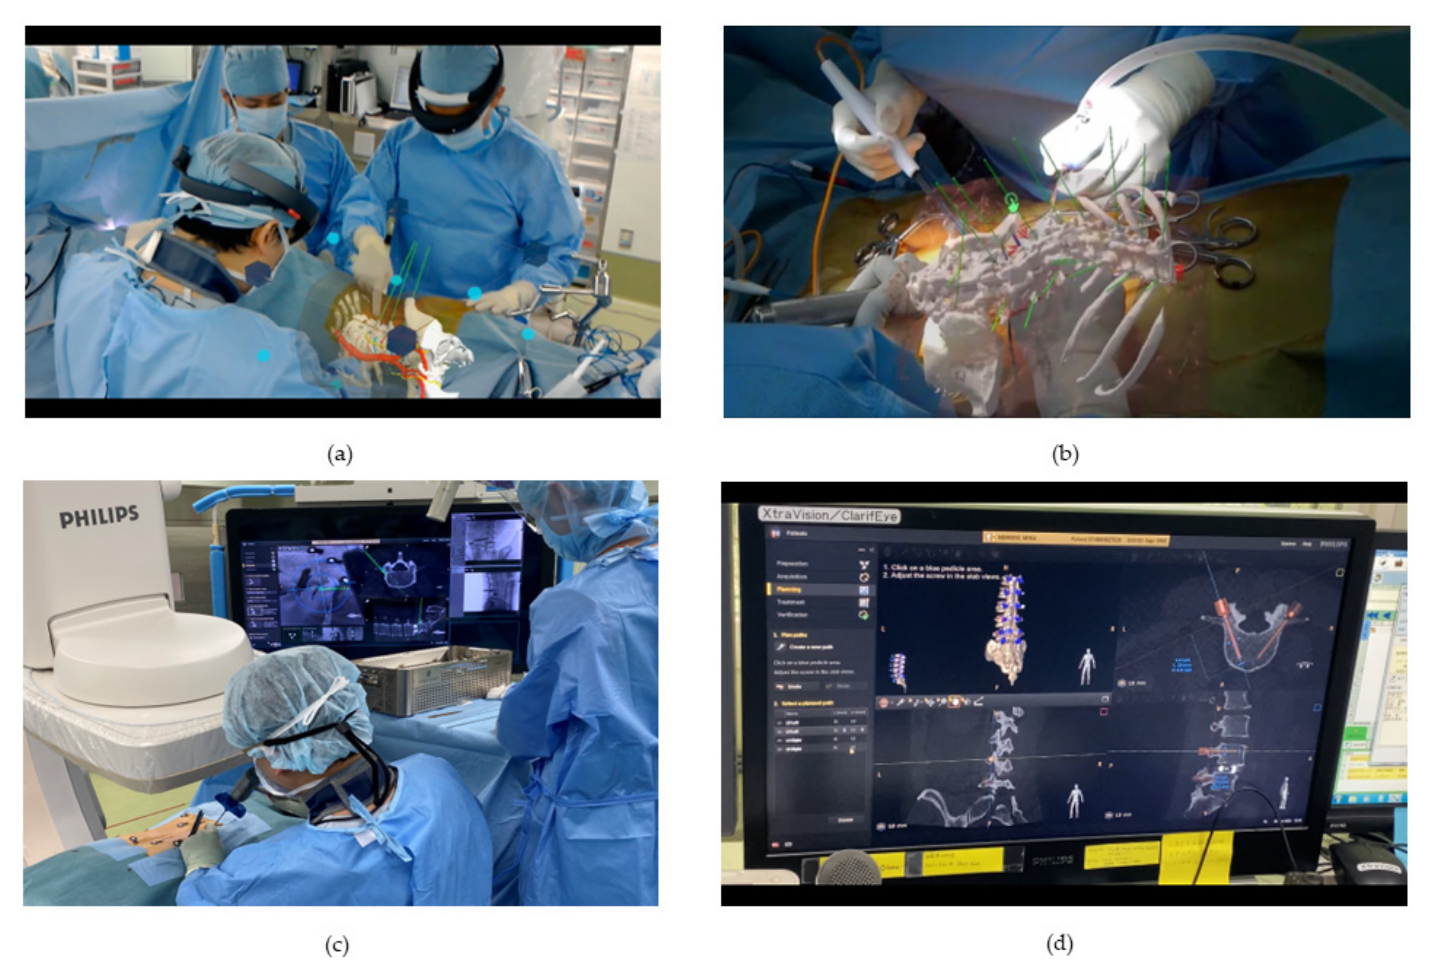
Figure 6. Mixed Reality (MR)-based navigation and Augmented Reality (AR) (ClarifEye ® )-based navigation for spinal surgery. ( a , b ) MR-based navigation. HoloLens can project 3D images of organs, blood vessels, and bones on the patient’s body. The same projection image can be shared between the operator and assistants intraoperatively; ( c , d ) AR (ClarifEye ® )-based navigation for spinal surgery. Video cameras are integrated into X-ray detector frame cover for tracking with noninvasive markers placed on the patient’s skin. Live display from the video cameras is augmented with 3D volume rendering of the spine and planned path of a pedicle